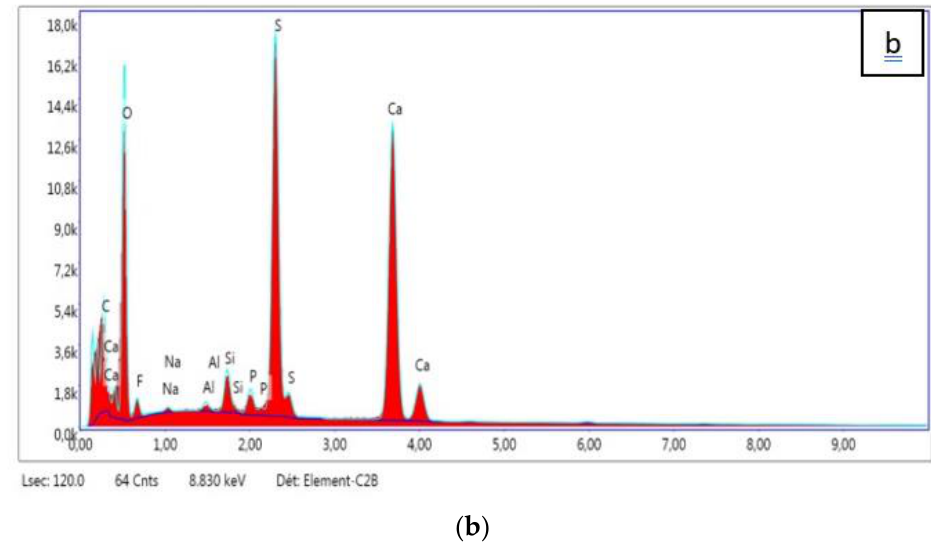
Figure 8. EDS results of PGT: Element map ( a ) and the quantitative ratio of the elements ( b ).